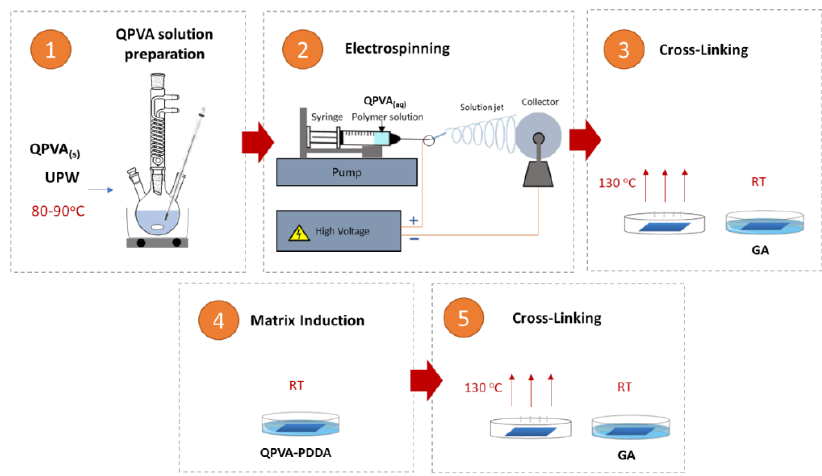
Figure 2. Schematic of preparation procedure.